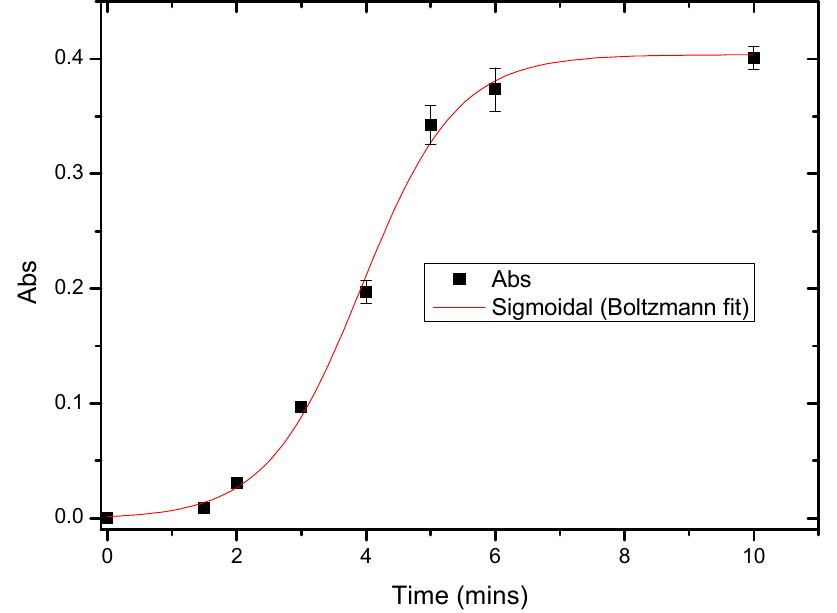
Figure 6. Absorbance (385 nm) vs. time for Urs/P(3HT- co -3TAA)/ITO glass assayed by Nessler’s reagent in 5 mM urea solution.